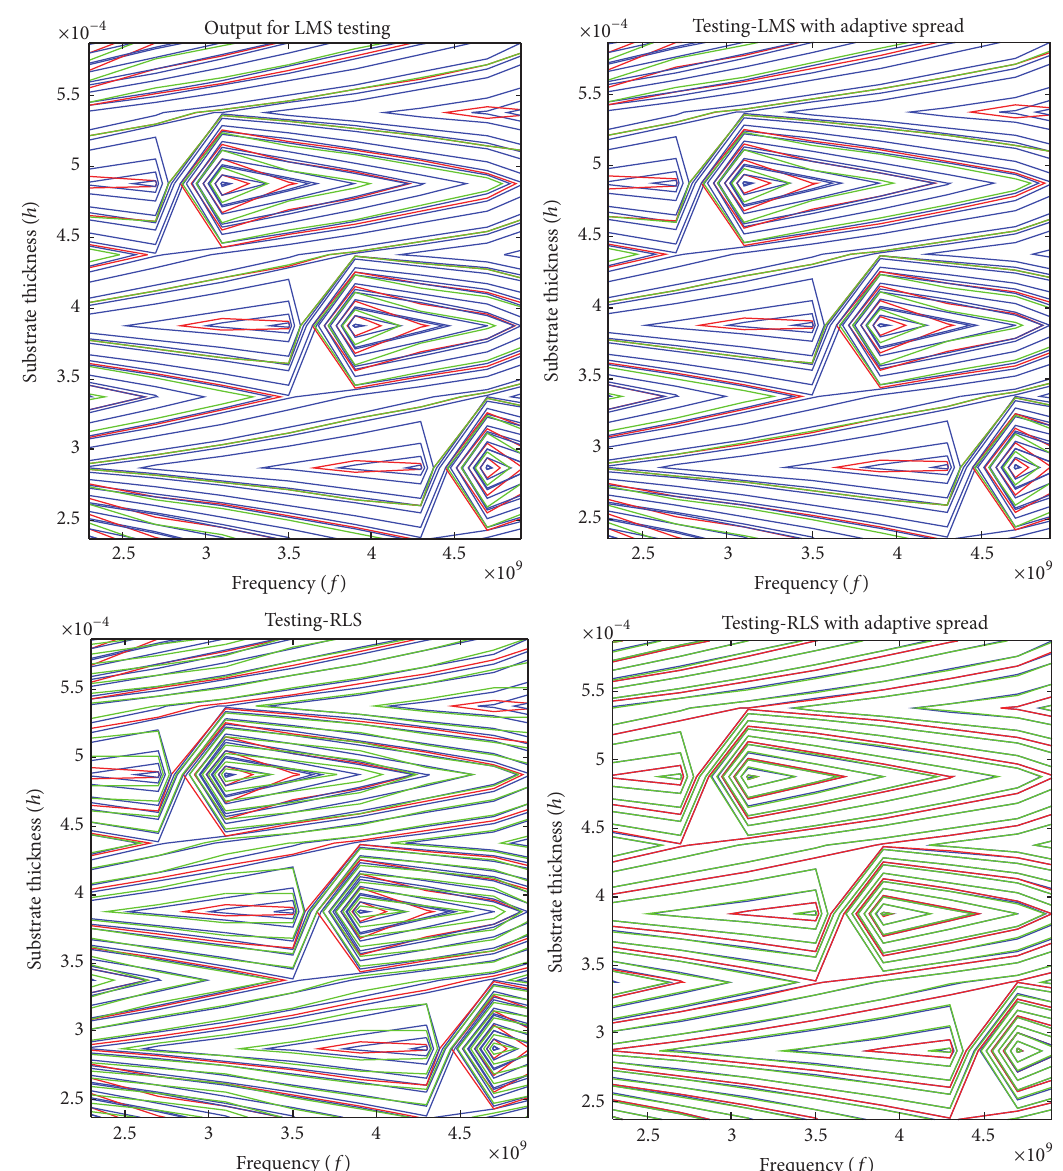
Figure 7: Contour plots of the LMS, RLS, and adaptive spread algorithms in MSA synthesis.